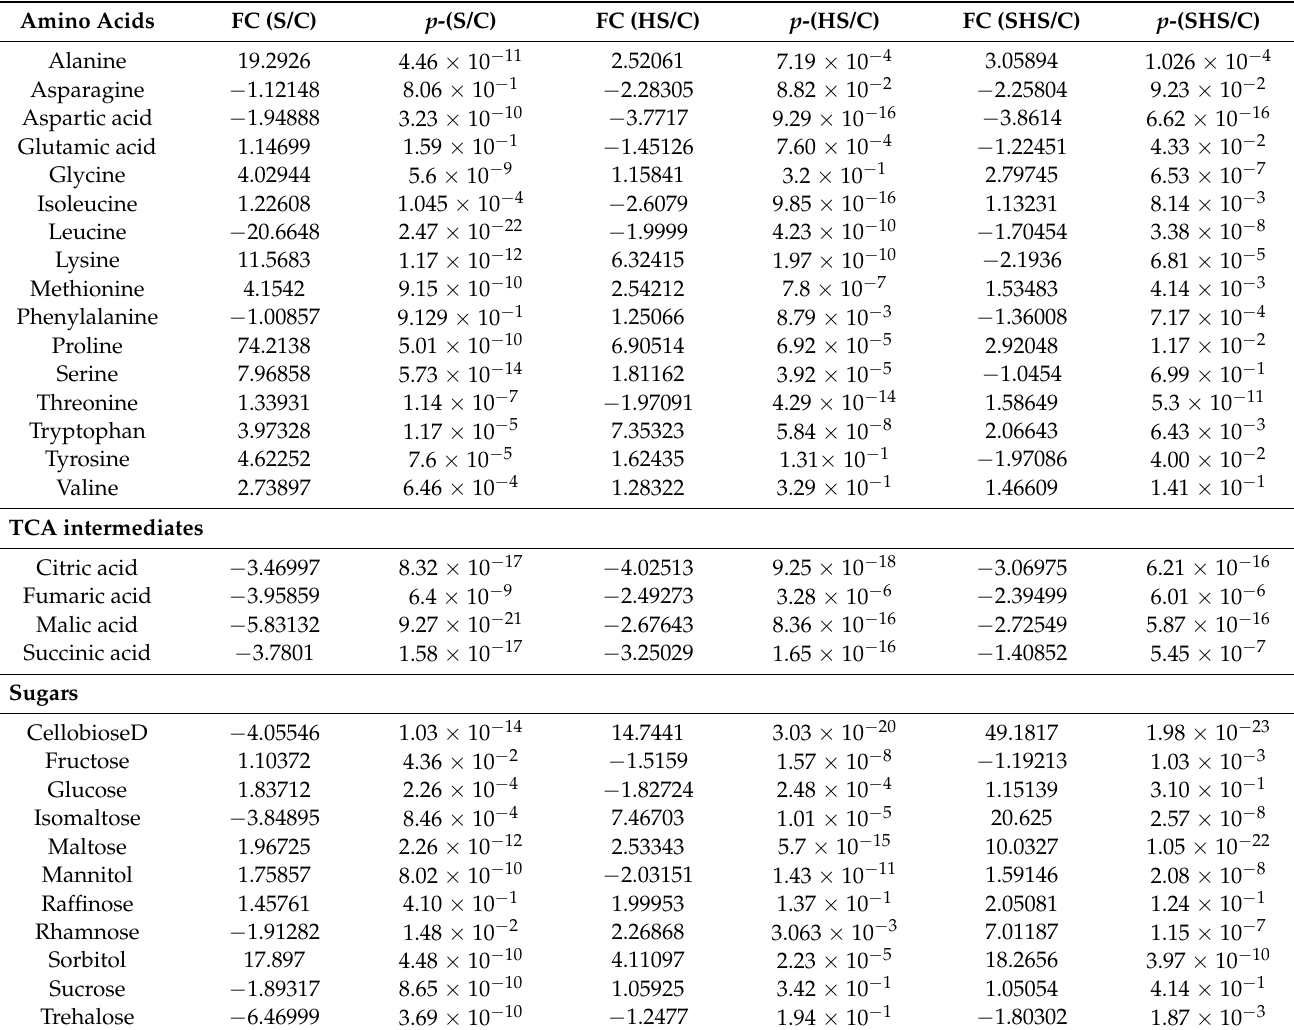
Table 1. Fold change (treatments vs. control) in levels of amino acids, TCA cycle intermediates and sugars ( p value for each comparison is given).